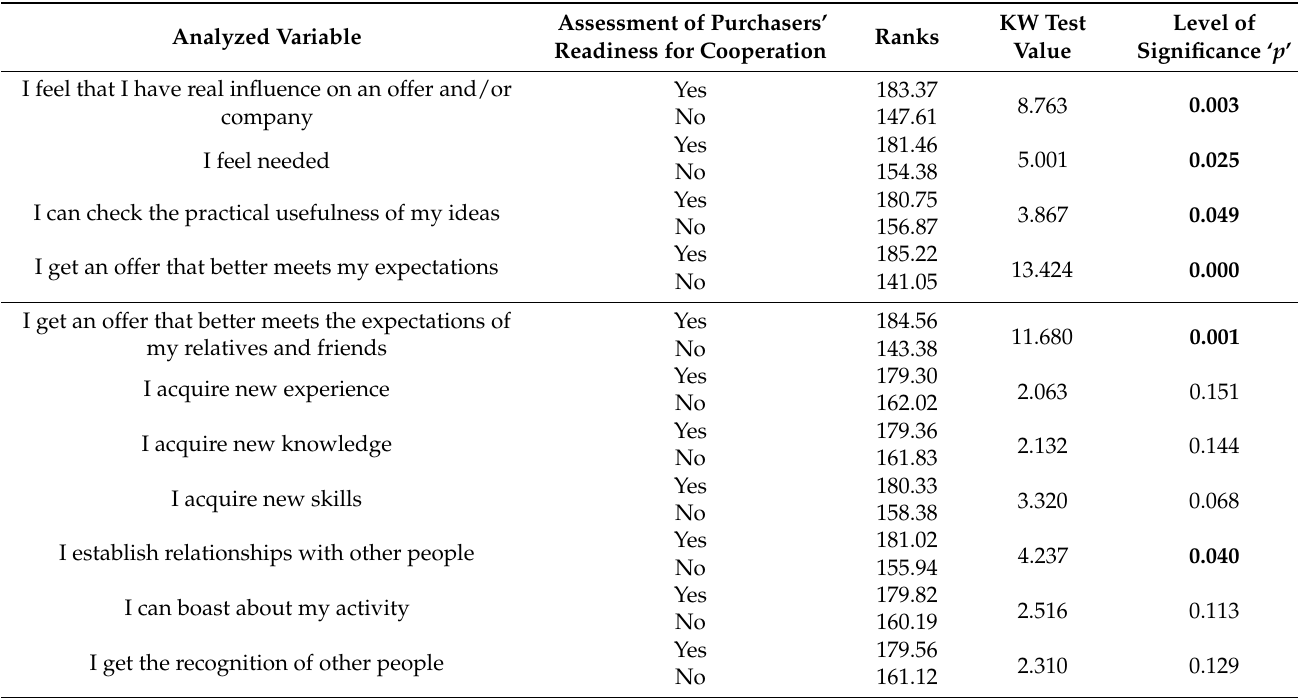
Table 8. Analysis of significance of differences between respondents’ opinions relating to the needs satisfied due to cooperation with offerors, according to the criterion of the assessment of purchasers’ readiness for such cooperation. Analyzed